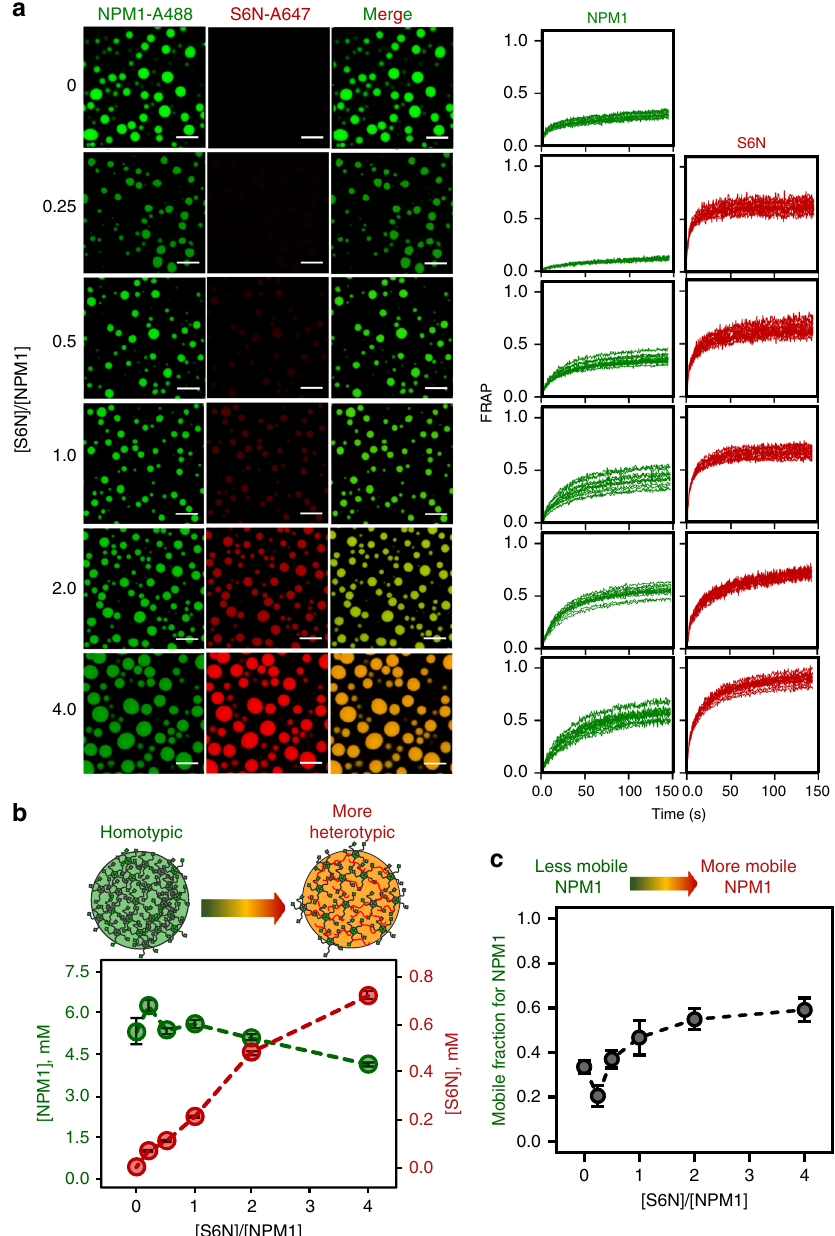
Fig. 4 S6N tunes the composition and material properties of NPM1 droplet scaffolds. a Fluorescence confocal microscopy images (left three columns) of droplets formed from different ratios of NPM1-A488 (left, green) and S6N-A647 (middle, red) in the presence of 5% PEG; the colors of the left and middle columns are merged in the right columns. The concentration of NPM1 (5 μ M) was constant and that of S6N was varied, as given by the [S6N]/[NPM1] values indicated on the left. FRAP recovery curves (right two columns) for NPM1-A488 (left, green) and S6N-A647 (right, red), respectively, for individual droplets at the corresponding [S6N]/[NPM1] values, where NPM1 (10 μ M) was constant; ROI = 1 µ m circular area in the center of the droplet. b Concentrations of NPM1 (green) and S6N (red) within droplets prepared at the indicated initial [S6N]/[NPM1] values in the presence of 5% PEG. The starting concentration of NPM1 (5 μ M) was constant. Protein concentrations inside droplets were determined using standard curves for both Alexa Fluor 488 and Alexa Fluor 647 in 5% PEG-containing buffer. Values represent mean ± s.d. for n ≥ 20 droplets. c Fraction of mobile NPM1-A488 molecules within droplets derived from FRAP prepared at the different [S6N]/[NPM1] values illustrated in b . Values represent mean ± SD for n ≥ 10